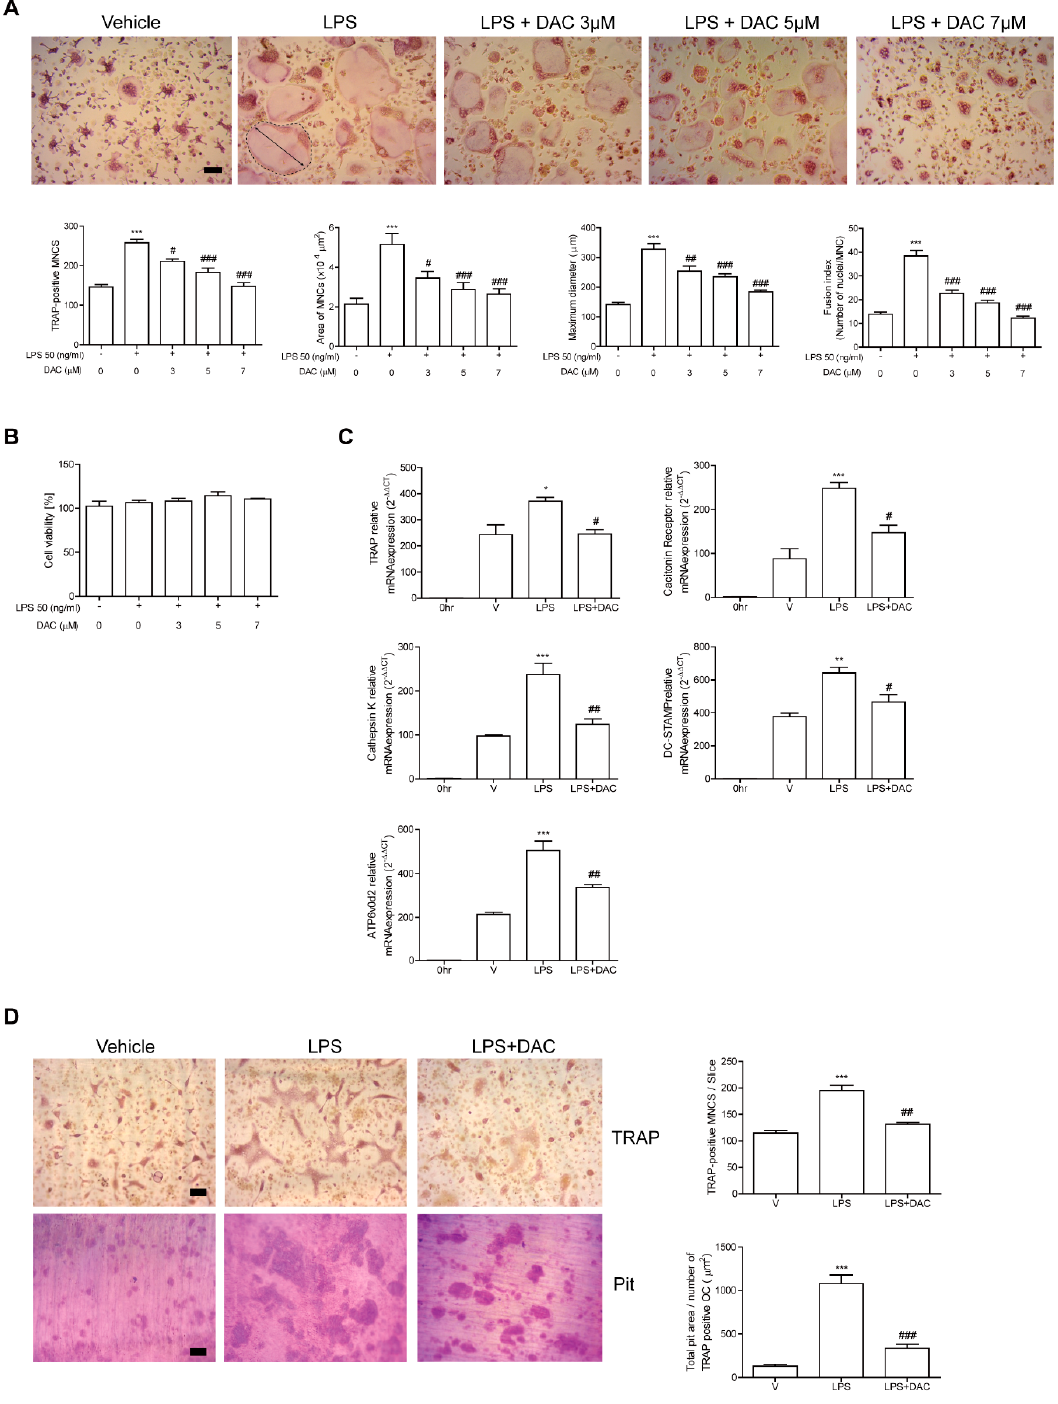
Figure 2. DAC decreases the differentiation and activity of OCs upon LPS stimulation in vitro . Bone marrow derived macrophages (BMMs) were cultured with M-CSF (30 ng/mL) and RANKL (40 ng/mL) for 40 h and further incubated with M-CSF and LPS (50 ng/mL) in the presence or absence of DAC (3 μ M, 5 μ M, or 7 μ M) for 48 h (A, B) or 24 h (C). PBS was used as a vehicle. After fixation with formaldehyde, TRAP-positive multinucleated cells (MNCs) were counted. More than 70 cells were randomly selected for measuring the area (marked with dotted line), maximum diameter (double arrow of the formed OCs), and fusion index (the number of nuclei per TRAP-positive MNCs). Representative photos are shown. Scale bar: 100 μ m in the representative OC photos ( A ). MTT assay